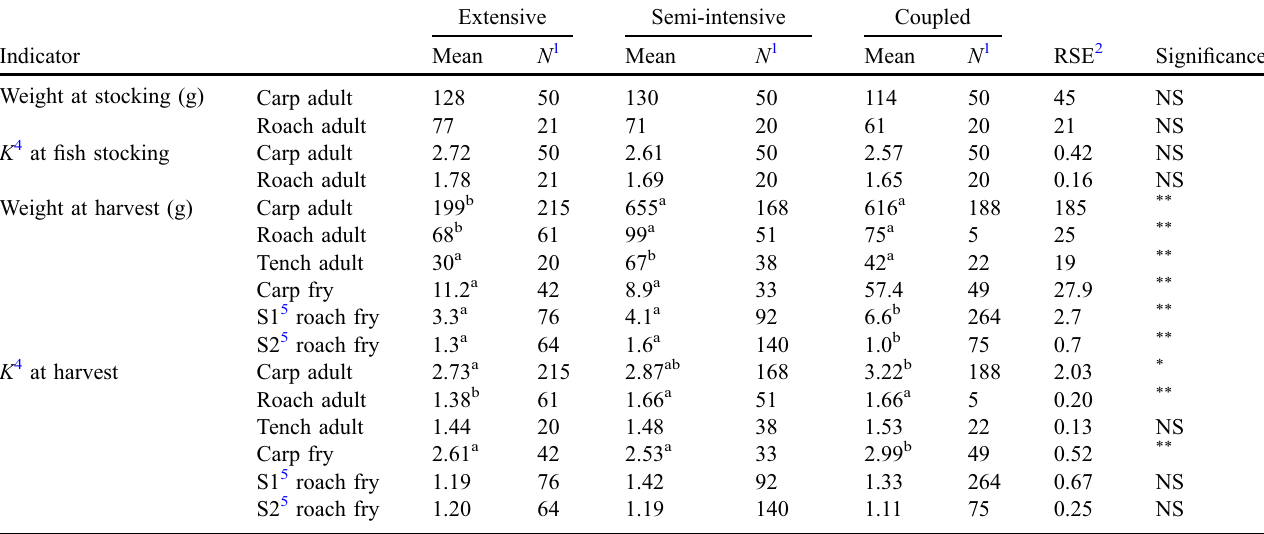
Extensive Semi-intensive Coupled